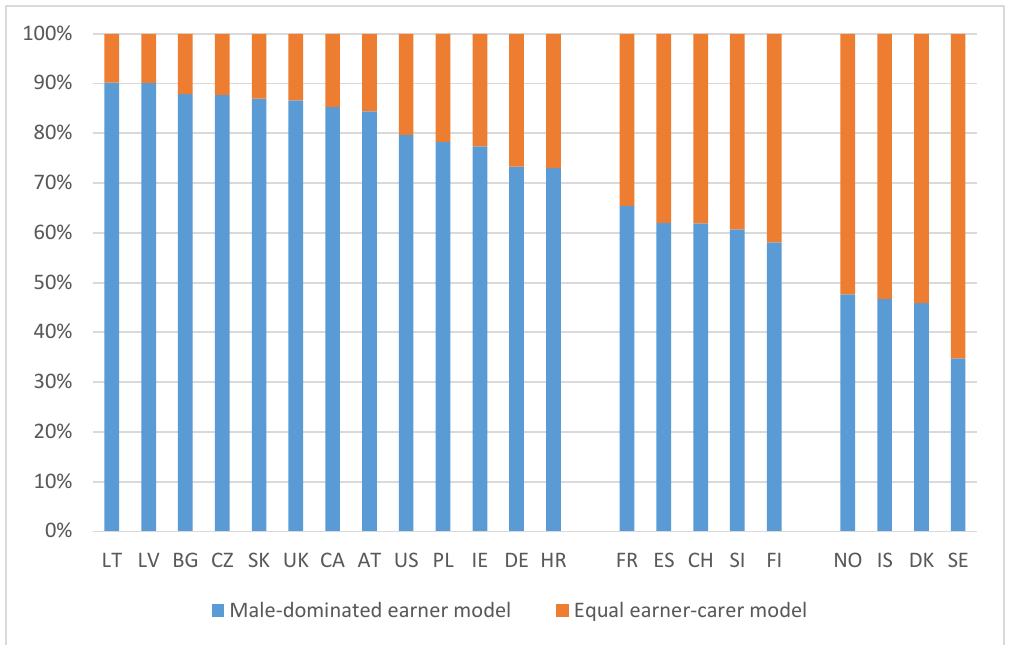
Figure 2. Attitudes to the male-dominated earner model and the equal earner-carer model, %.